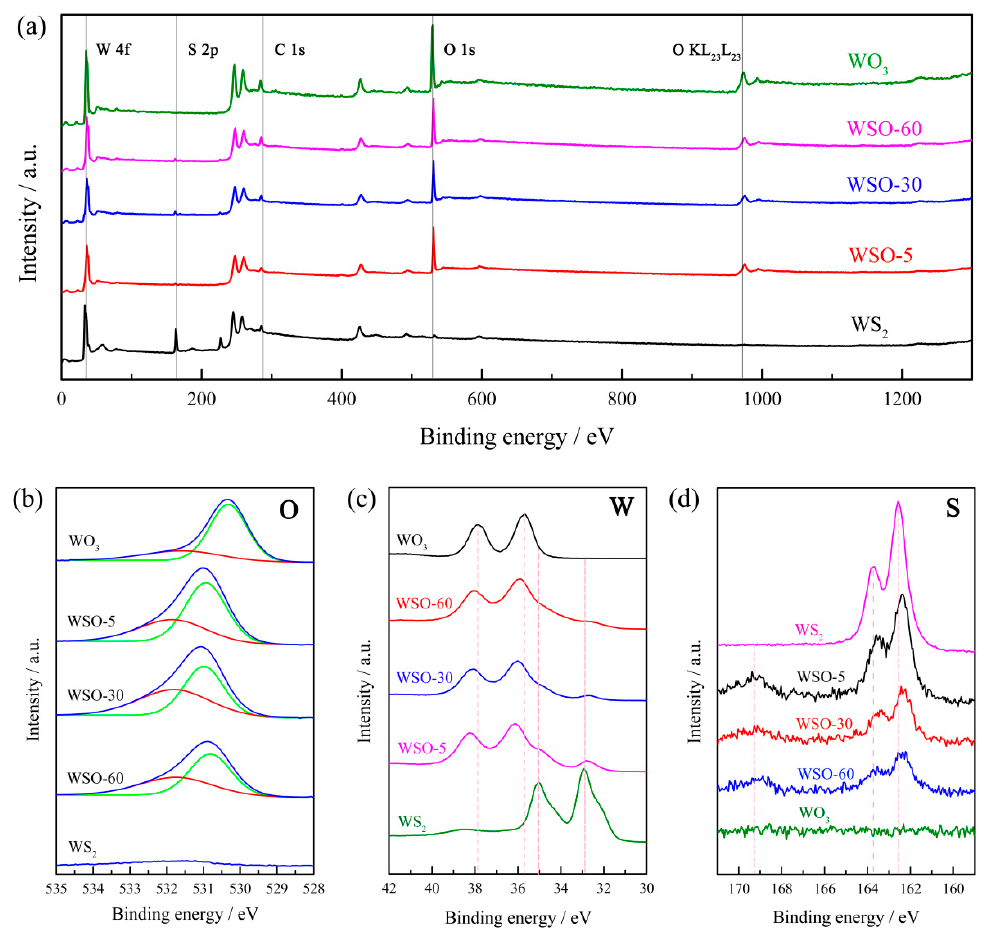
/ WO 3 , and WO 3 . ( a ) Full-range XPS spectra, ( b ) O 1s spectra, ( c )